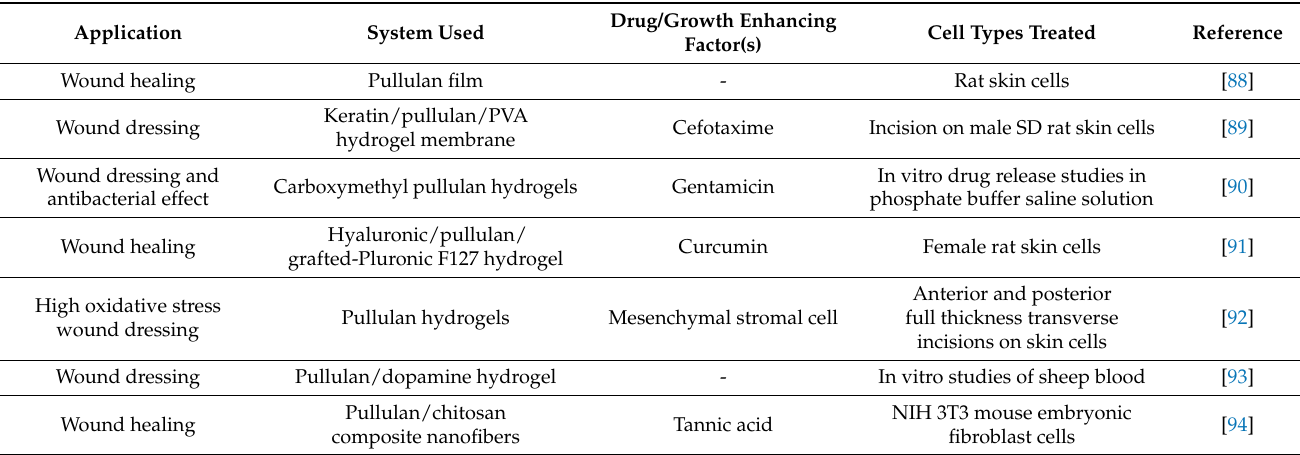
Figure 8. ( a ) Measurement of wound area by treatment group ( b ) Wound size at POD 10 ( c ) Days until total wound closure by treatment group (* p < 0.05, ** p < 0.01). C = control, P = Promogran™, F = Fibracol ® Plus, and T = TauTona Wound Dressing (TWD), Pullulan/collagen dressing. POD = Postoperative day. Reproduced from the article [85], with permission from Wiley 2022. Table 3. Additional pullulan-based hydrogels wound